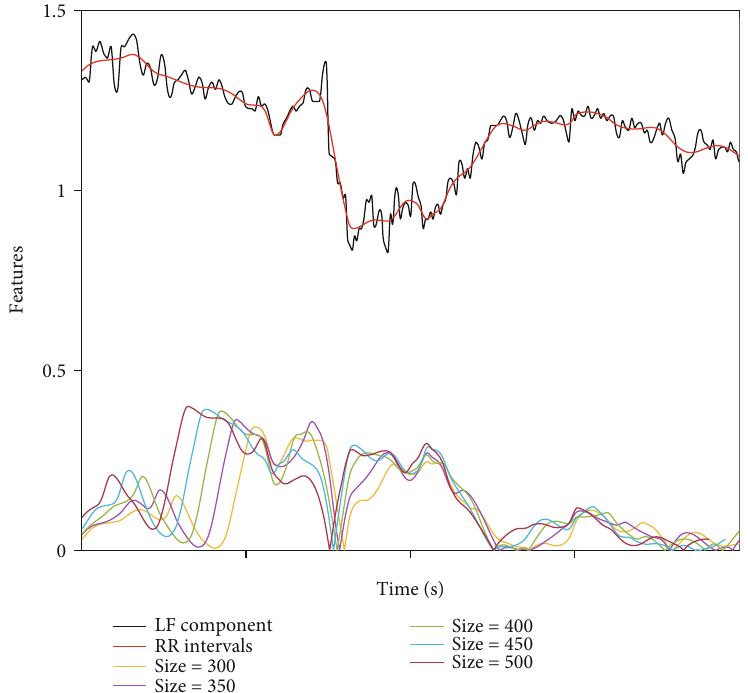
Figure 4: The extracted features corresponding to window sizes between 300 and 500 sampling points.